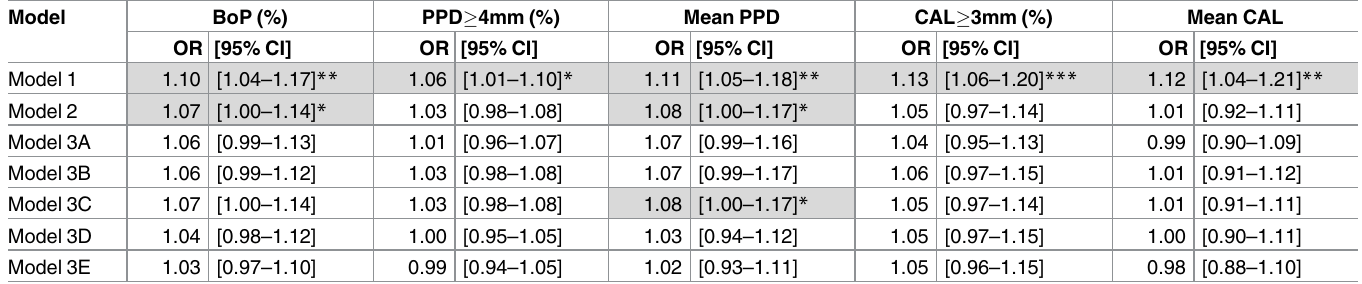
Table 2. Models for the association between indicators of periodontitis and steatosis (n = 8172).